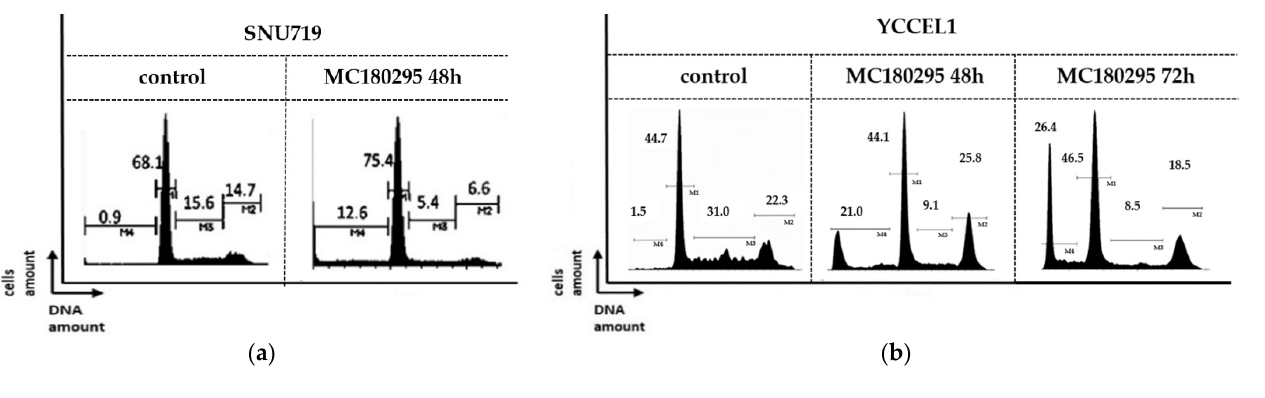
Figure 2. Cell cycle analysis after MC180295 treatment in SNU719 ( a ) and YCCEL1 ( b ). The percentage of cells in S phase decreased, and those in the sub-G1 fraction increased at 48 h after treatment. In YCCEL1 cells, the percentage of cells in the sub-G1 fraction increased to 26.4% at 72 h after MC180295 treatment.